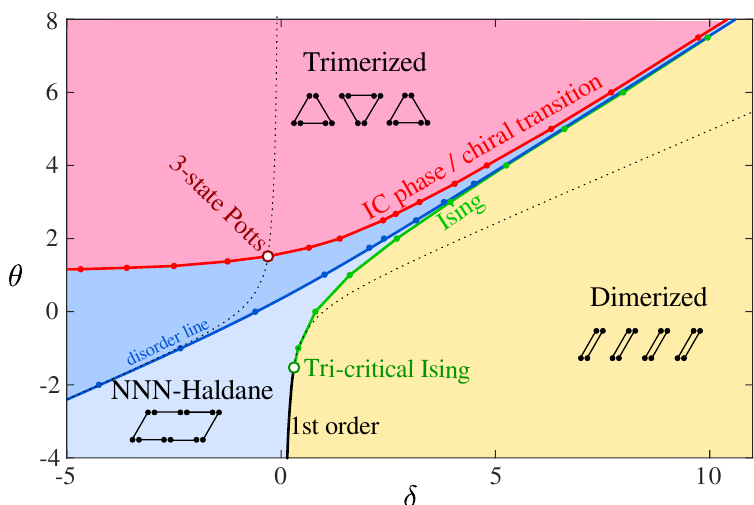
Figure 15: Phase diagram of the quantum loop model of Eq.13 as a function of δ and θ . It has been deduced from the hard boson phase diagram shown of Fig.8 using δ = − U − V and θ = − U /